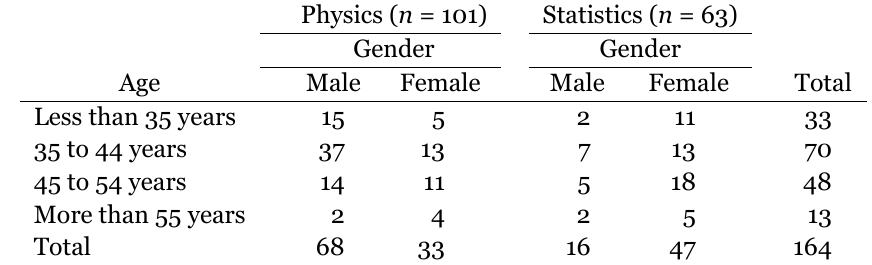
Physics ( n = 101) Statistics ( n =